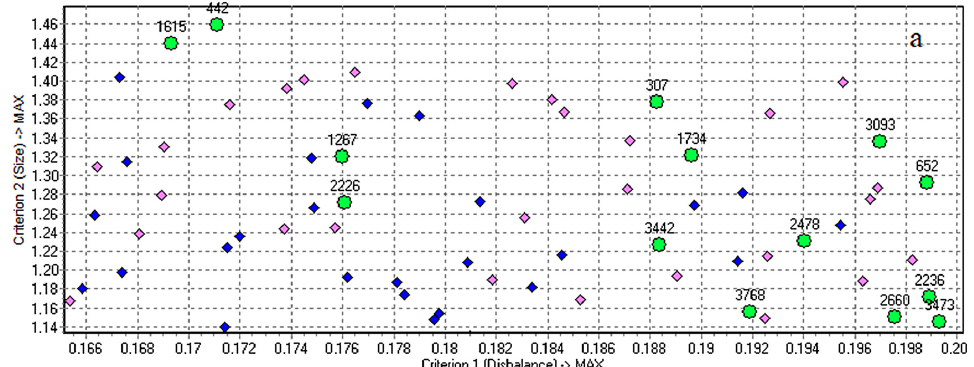
Figure 10. An extended set of solutions in the scaled space of criteria: K 1 and K 2 .